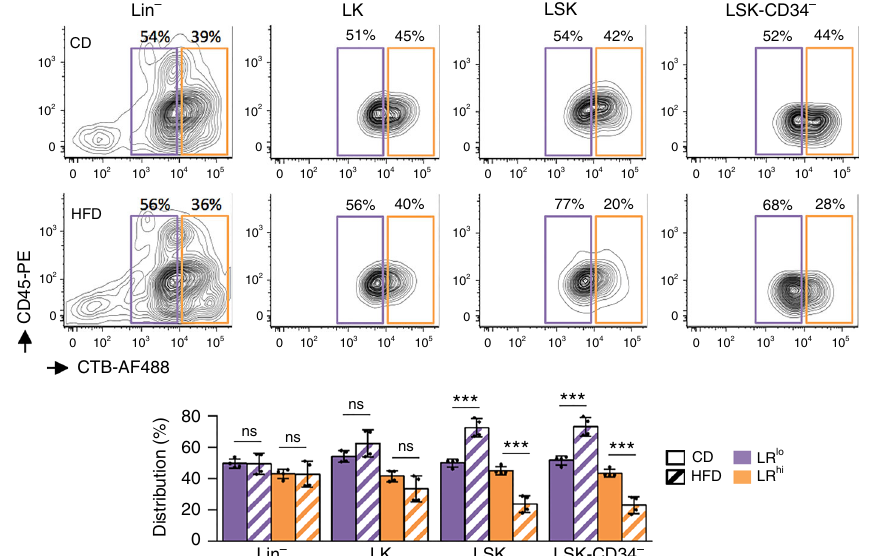
Fig. 2 HFD affects the population of HSC expressing high level of lipid rafts in BM. The population of cells displaying a high level of lipid rafts (LR) (LR hi ) among LSK-CD34 − cells decreases when mice are fed with a HFD. Data show results on HSC (LSK-CD34 − ), early progenitors (LSK) and more mature progenitors (Lin − and LK). Data show mean ± SD; n = 4 mice per diet group; ns, non-signi fi cant ( P > 0.05); *** P < 0.001 (two-tailed unpaired Student ’ s t -test)